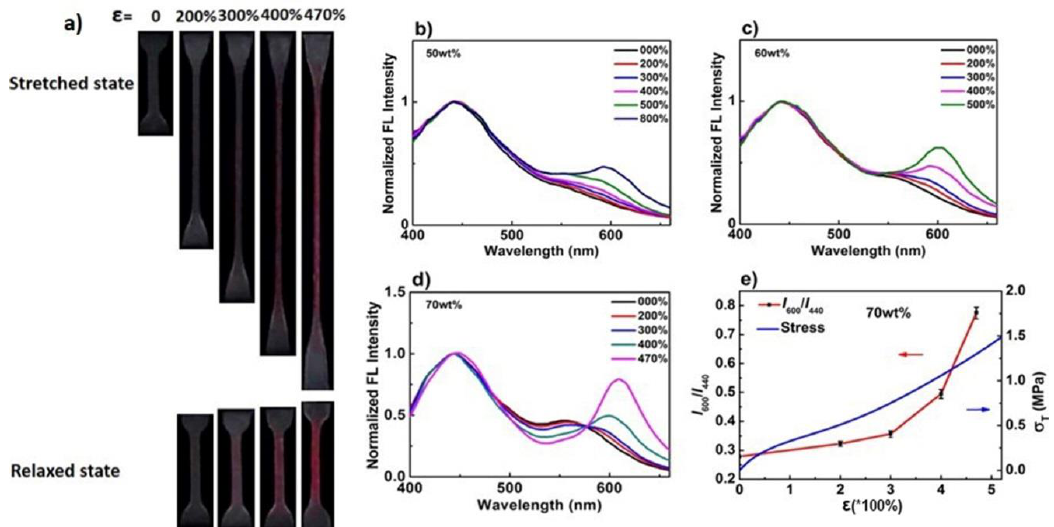
Figure 4. ( a ) Fluorescent images of poly(AAm-co-MA/Rh) hydrogel with a solid content of 70 wt% at both stretched state and the corresponding relaxed state. Emission spectra of the hydrogel with a solid content of ( b ) 50 wt%, ( c ) 60 wt%, and ( d ) 70 wt% recorded at increasing strain levels during uniaxial stretching. ( e ) Stress and fluorescence-intensity ratio I 600 / I 440 as a function of stretch ratio for the hydrogel with a solid content of 70 wt%.